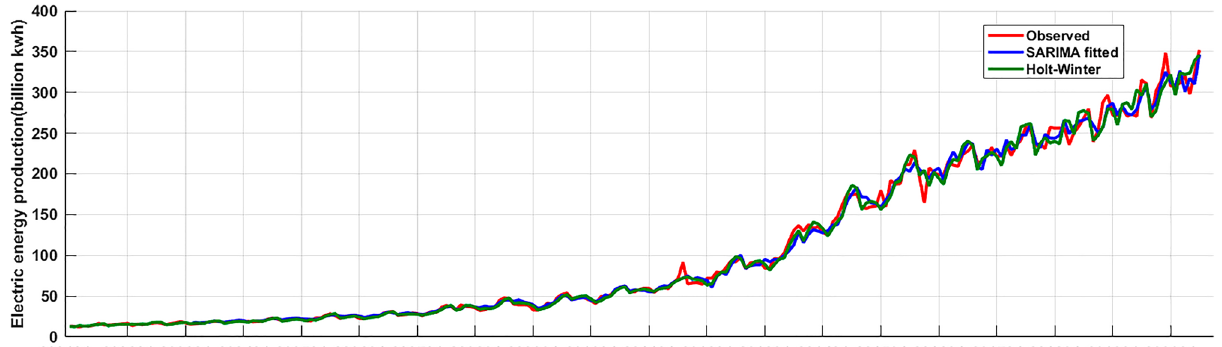
Figure 9. The comparison of fitting effects of the SARIMA((1,2,3,4,6,7,11),2,1)(1,0,1)12 model and the Holt- Winters’ multiplicative model (since the x-axis length is limited, only the January location of each year is marked in the